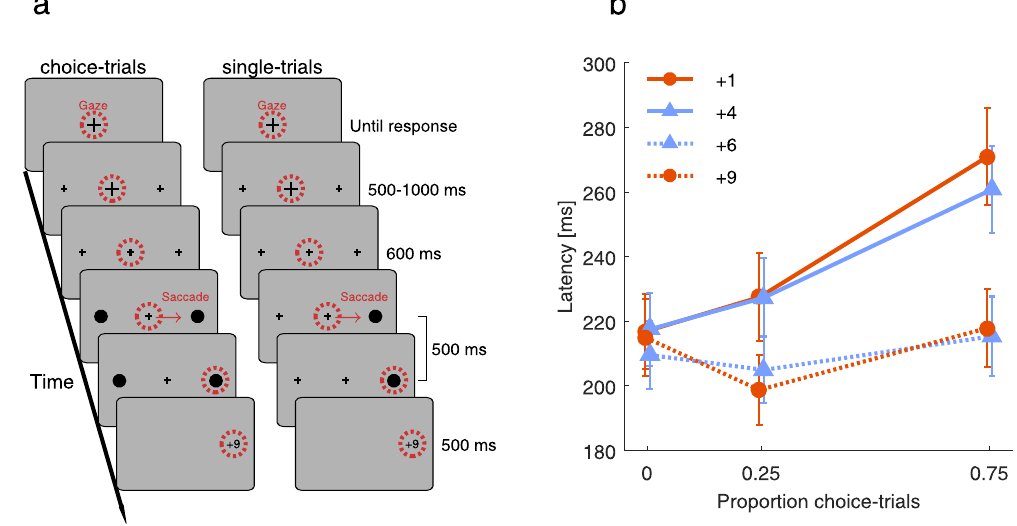
Figure 1. The effect of choice- on single-trials. ( a ) Trial procedure for choice- (left column) and single-trials (right column). Participants started trials by fixating the cross at the screen center (red dashed circle, not shown in the experiment) and simultaneously pressing a button on a keyboard. Two placeholders appeared in the periphery and after a random interval, the central fixation cross changed its size to indicate the onset of the target(s) in 600 ms. In single-trials, one target (black dot) replaced one of the two placeholder crosses and was displayed for 500 ms. Participants received a reward if they saccaded to the target during its presentation. In choice-trials, both placeholders turned into dots and participants could choose which target to saccade to in order to obtain the corresponding reward. Each side was either assigned a highly or a less rewarded target and participants were informed about the distribution of rewards before starting each block. ( b ) Latency in single-trials as a function of the proportion of choice-trials in the same block. Dashed lines refer to the highly rewarded, solid lines to the less rewarded targets. Blue colors and triangles denote the small, orange colors and circles the large reward difference. Error bars are 95% confidence intervals. Values are offset horizontally for better